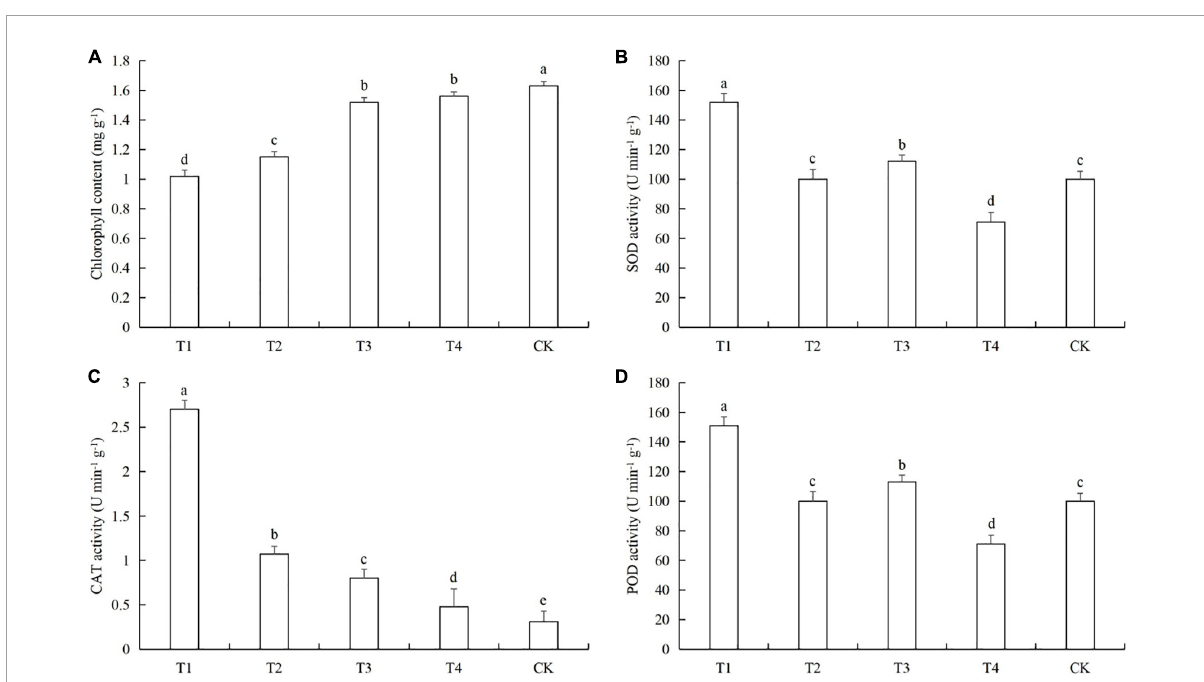
FIGURE3 Effects of different aphid densities on (A) chlorophyll content and the activities of (B) superoxide dismutase (SOD), (C) catalase (CAT), and (D) peroxidase (POD) in cucumber leaves. T1, 160 aphids; T2, 80 aphids; T3, 40 aphids; T4, 20 aphids; CK, 0 aphids. The mean value ± p < 0.05 error bar data were presented in the figure and different alphabetical letters indicate the significant differences between the aphid density treatments.